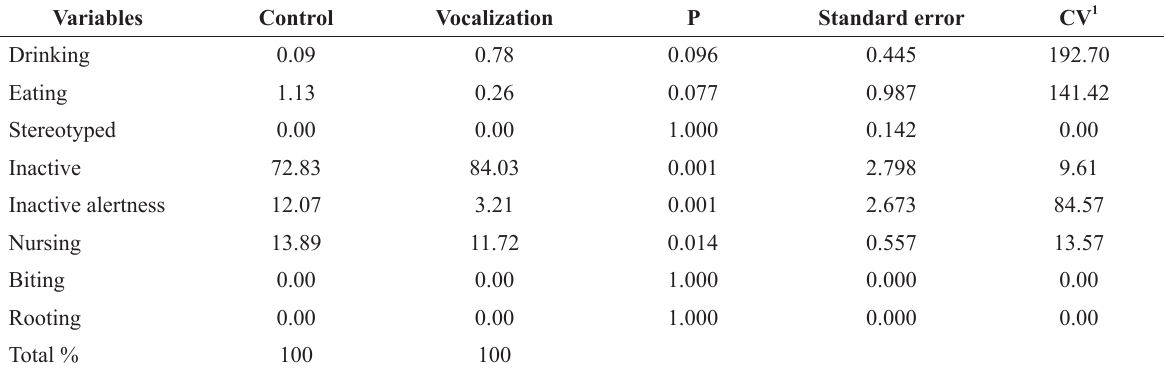
Behavior average daily frequencies (%) of sows due to the use of artificial vocalization or not at 15 days of lactation.